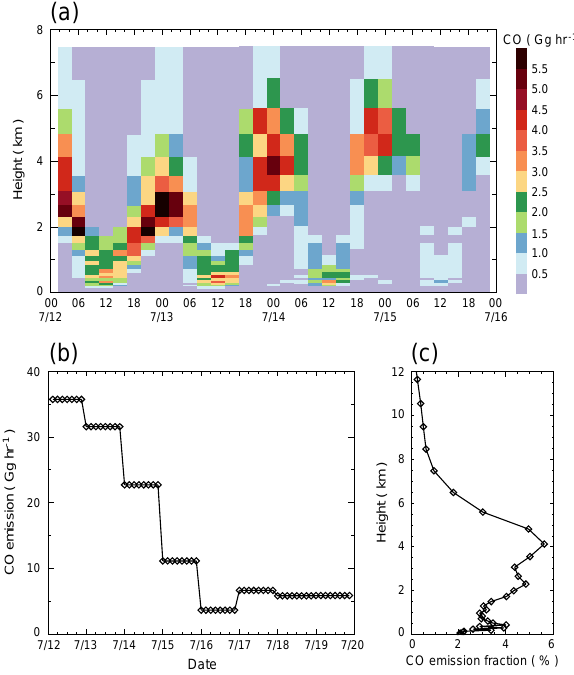
Fig. 3. (a) Vertical and temporal distribution of the model-estimated wildfire CO emissions in Alaska from 12 July to 15 July. (b) Tem- poral distribution of the wildfire CO emissions averaged over the Alaska area from 12 July to 19 July. (c) Mean vertical fraction of the injected wildfire CO emissions averaged over Alaska during the same time